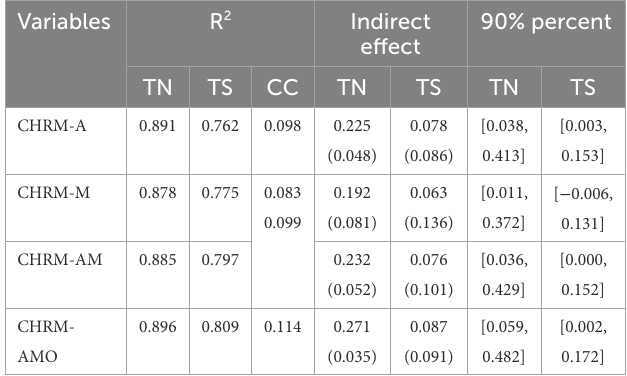
TABLE 6 Comparison of total effects between different dimensions in CHRM. Variables